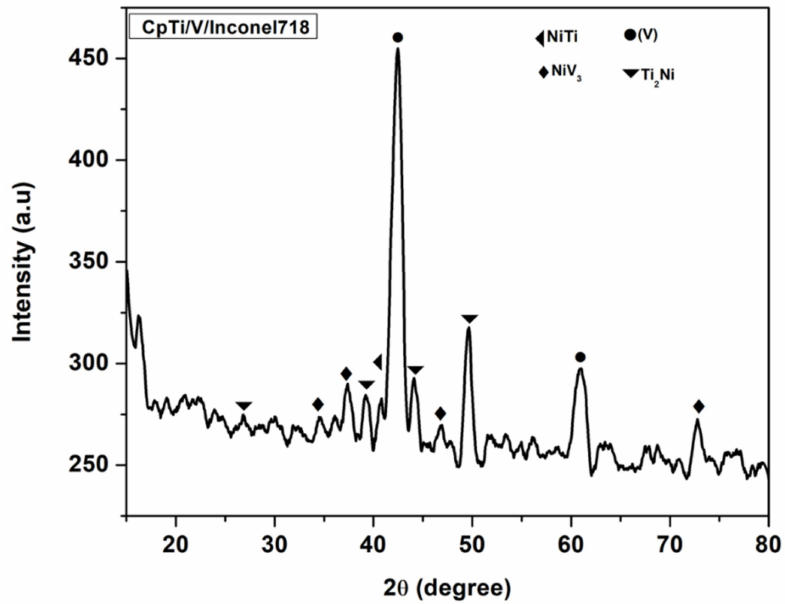
Figure 5. XRD spectra of the CpTi/V/IN718